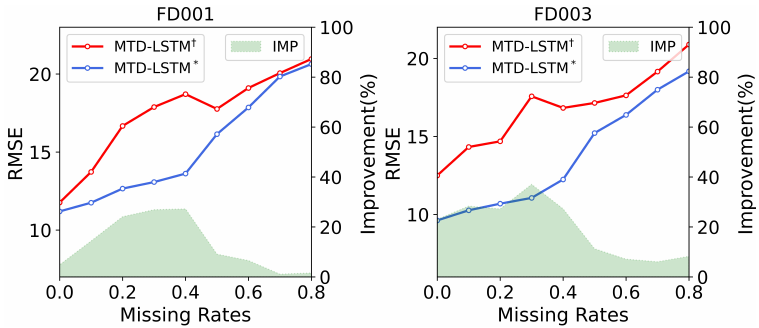
Figure 7. The prediction accuracy comparison of MTD-LSTM † and MTD-LSTM ∗ on FD001 and FD003.